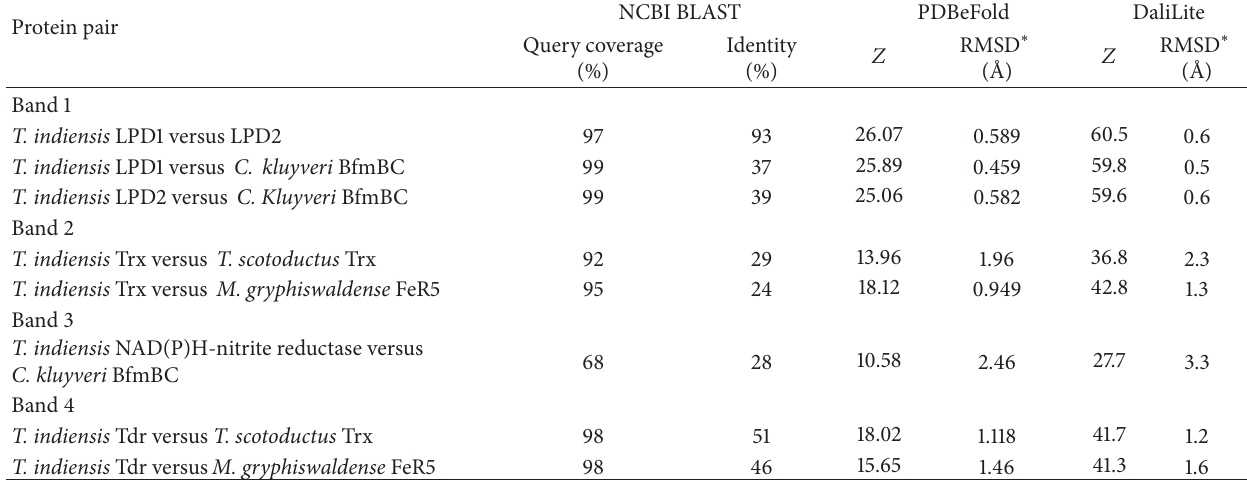
Table 4: Pairwise sequence and structural similarity of T. indiensis proteins with Fe(III) reductases. Protein